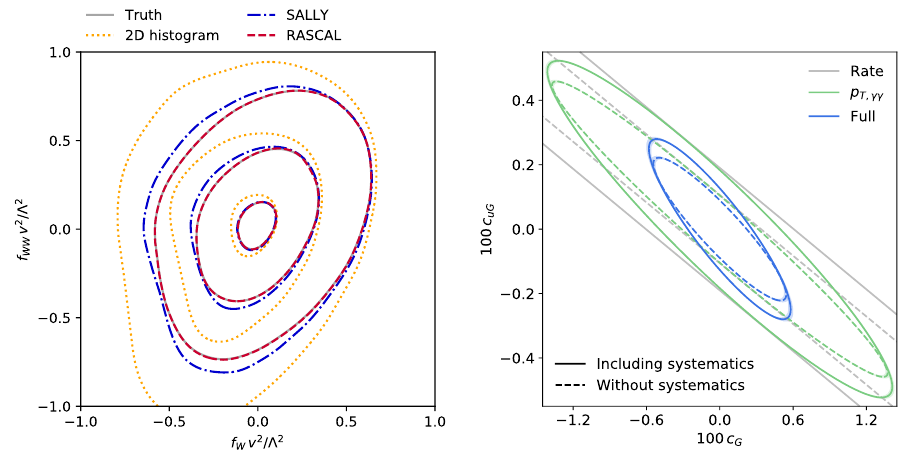
Figure 2. Left: Expected 68%, 95%, and 99.7% confidence level limits as a function of the two Wilson coe ffi cients f W and f WW , rescaled with the Higgs vacuum expectation value v and scale of new physics Λ . The measurement is performed with events from Higgs boson production via vector boson fusion. The exclusion limits with S ally improve the performance over a histogram-based approach. The limits with R ascal are indistinguishable from those obtained by using the true likelihood ratio. Additional details are provided in references [9, 10]. Right: Expected 68% confidence level limits as a function of two Wilson coe ffi cients, c G and c uG , from an analysis of the ttH process with Higgs boson decays to a diphoton final state. The results shown in green are based on using a histogram binned in the transverse momentum of the diphoton system, the results in blue use S ally . The gray line corresponds to the limits when only making use of rate information. More details are provided in reference